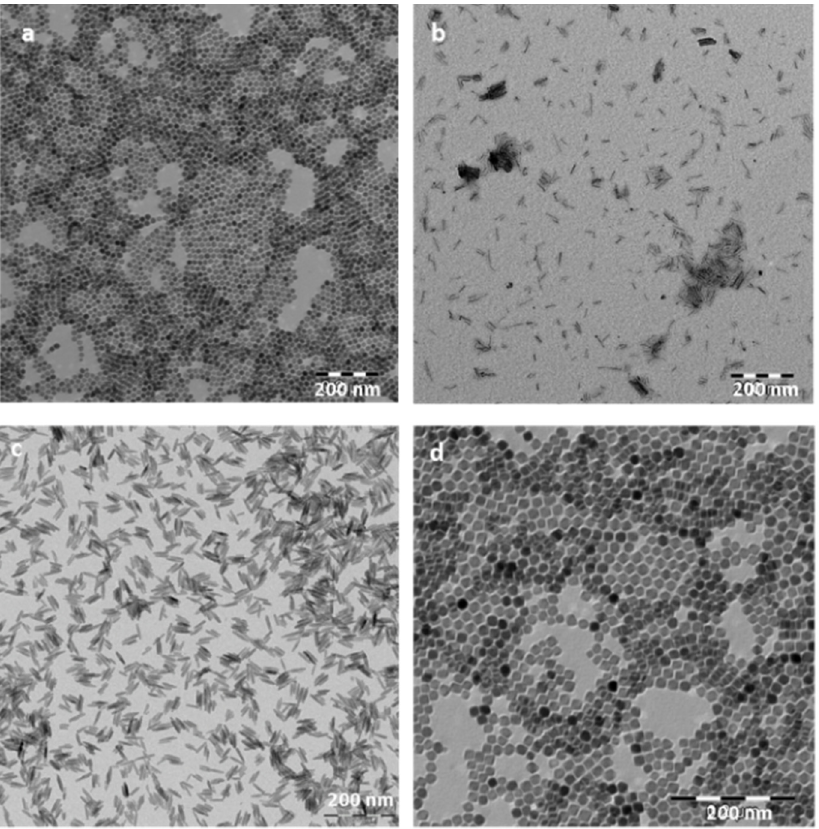
Figure 5. Transmission electron microscopy (TEM) images of the iron oxide nanoparticles (magnetite) prepared by the hydrothermal method with different morphologies: ( a ) spheres, ( b ) rods, ( c ) needles, and ( d ) cuboidals. Images were obtained using a LIBRA 120 Plus Carl Zeiss microscope (A Carl Zeiss SMT AG Company, Oberkochen,